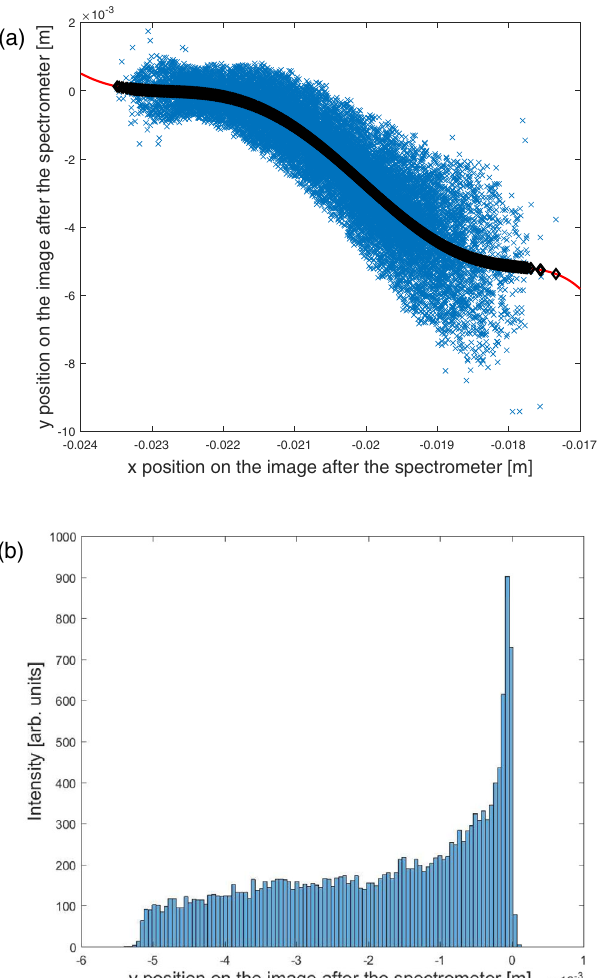
FIG. 5. (a) Simulation results of the two-dimensional particle distribution projected on screen-6, and (b) the corresponding pencil beam ’ s intensity distribution f ð y Þ . The black diamonds with red curve in (a) represent the projection of the pencil beam.